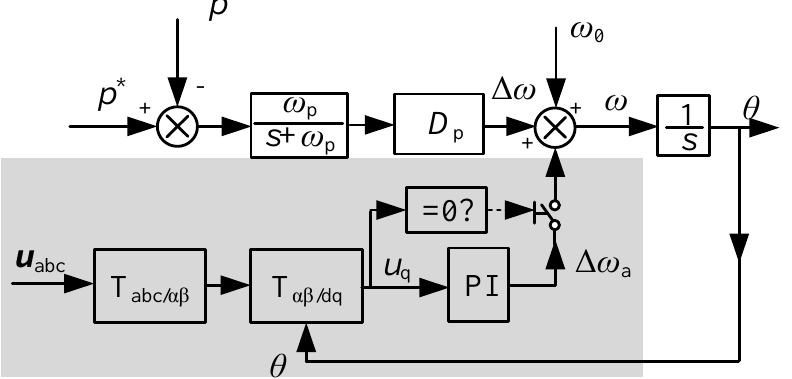
Figure 14. P-f loop with auxiliary synchronization unit.